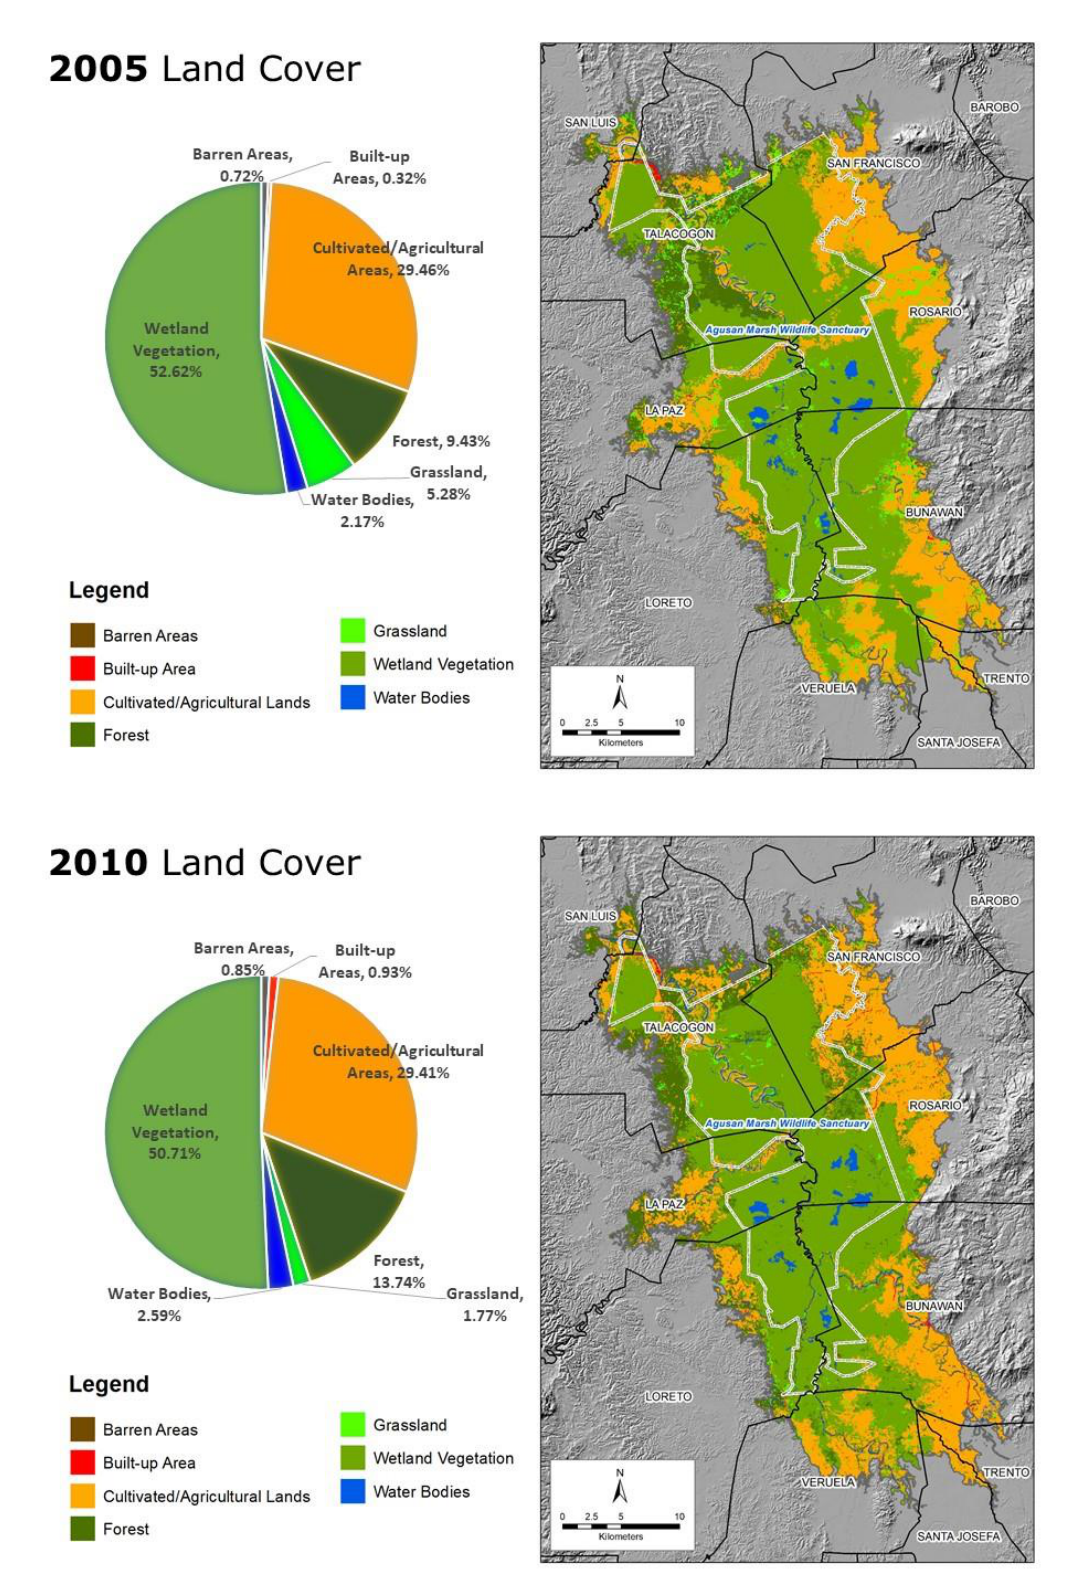
Figure 5 . Land-cover maps and statistics of the Agusan Marsh derived from multi-temporal Landsat images for the years 2005